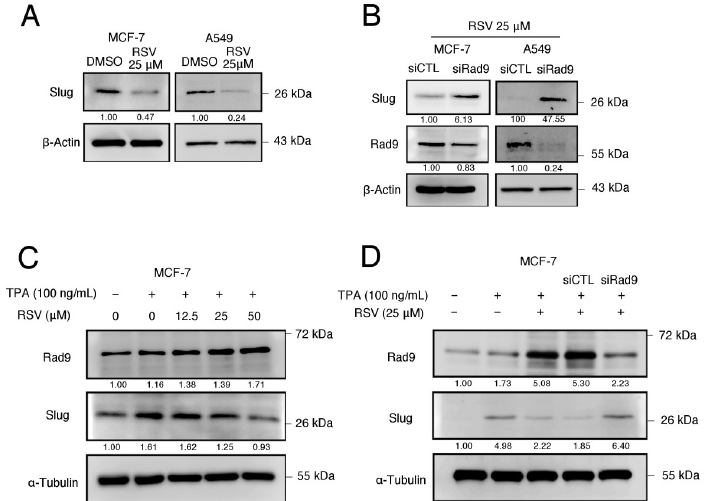
Fig 8. RSV inhibited Slug expression in a Rad9-dependent manner. (A) Western blotting was used to examine the effects of RSV treatment on Slug and Rad9 protein expression. (B) Immunoblotting analysis was performed to determine the effects of RSV treatment and Rad9 gene silencing on Slug protein expression. (C) Western blotting was used to examine the effect of phorbol-12-myristate-13-acetate (TPA) treatment with or without RSV on Rad9 and Slug protein expression. (D) Immunoblotting analysis was performed to determine the effects of TPA treatment with or without RSV and Rad9 gene silencing on Rad9 and Slug protein expression. β -Actin and α -tubulin were used as a loading control. Signals on the western blots were analyzed by ImageJ, normalized with that of β -Actin or α -Tubulin.